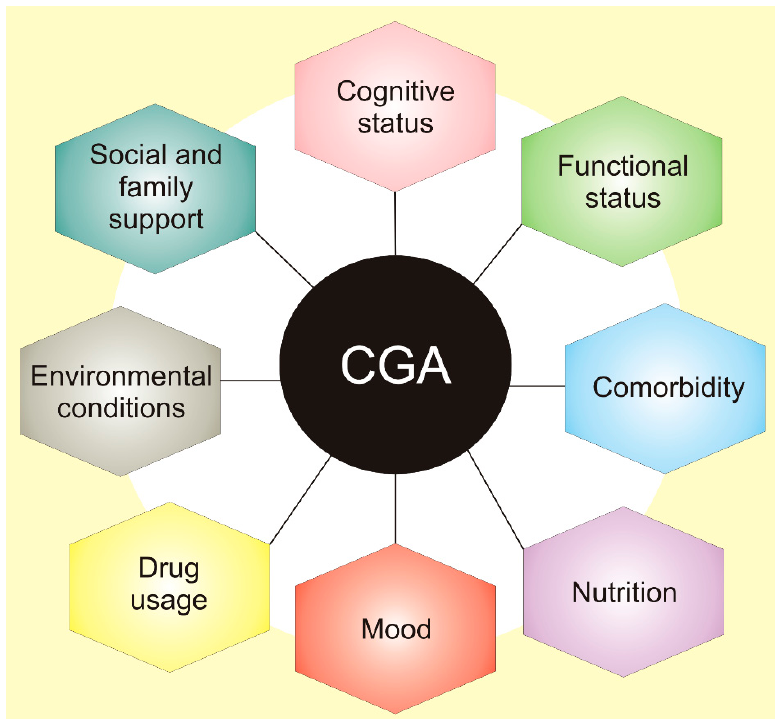
Figure 2. Comprehensive geriatric assessment (CGA) is an organized evaluation method to provide a multidisciplinary assessment of and care for the elderly. It assesses physical medical conditions, including comorbidity, the disease severity, immunization status, and others. Assessment of functional status refers to an elderly person’s ability to perform daily tasks and determines several core functions, including balance and mobility. Other areas of CGA include issues contained in broad categories of assessment of social health and environment.